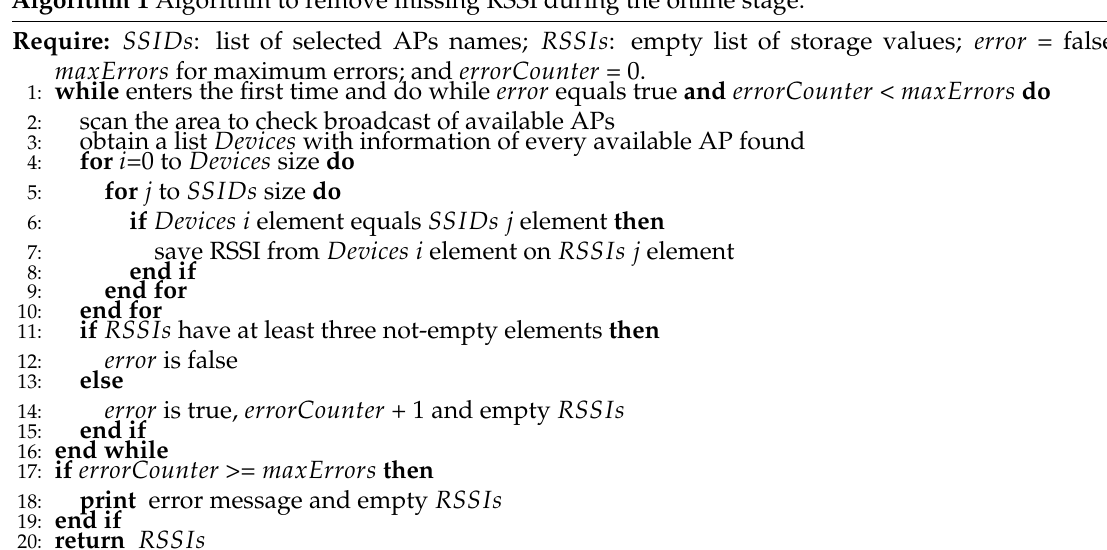
Algorithm 1 Algorithm to remove missing RSSI during the online stage.